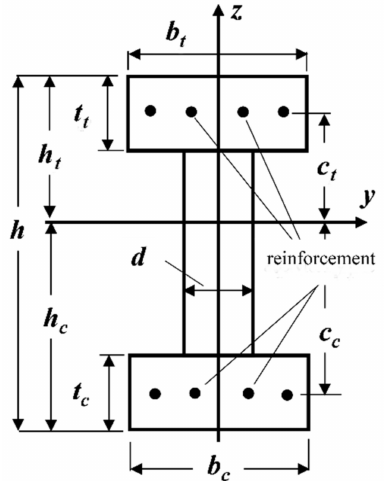
Figure 1. Calculation scheme: ( b t ) beam width in tension zone; ( b c ) beam width in the compressed zone; ( h ), ( h t ), ( h c ) beam height, beam height in tension and compressed zones; ( t t ), ( t c )the dimensions of the flanges in the stretched and compressed zones; ( d ) web